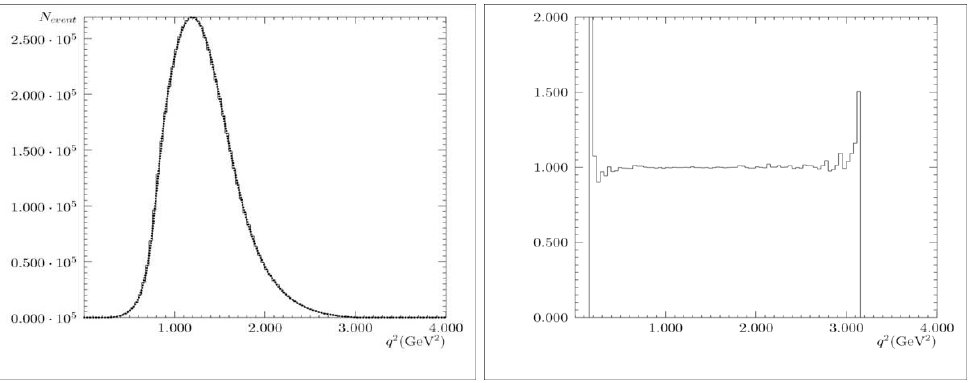
0 π 0 π − /dq 2 (left) and the ratio of the MC and the analytical